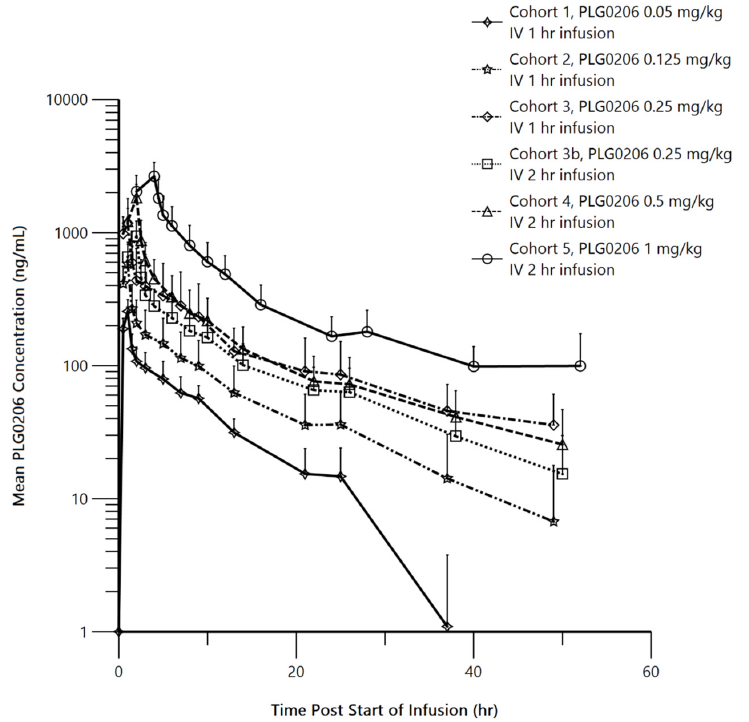
Figure 2. Mean (SD) PLG0206 plasma concentration (in log scale) time plots by dose group. IV, intravenous; hr, hour. Reproduced with permission from Huang et al., 2021 [25] .